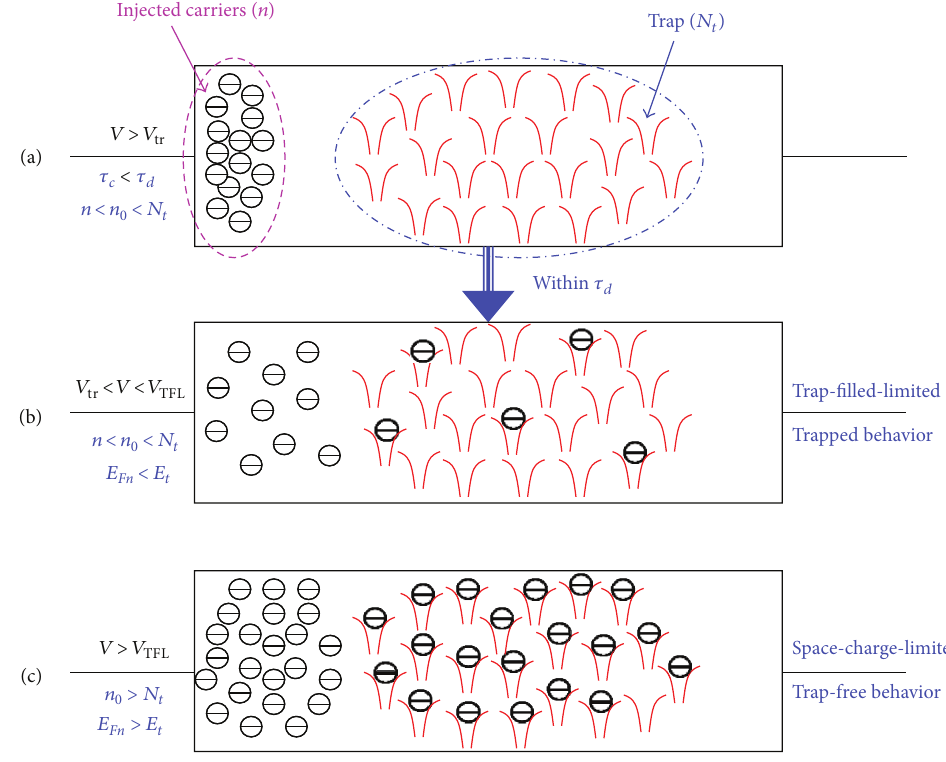
Figure 26: Carriers distribution in dielectric film under carrier strong injection ( 𝑉 > 𝑉 tr ) in space-charge-limited conduction. (a) Strong , 𝑛 < 𝑛 0 < 𝑁 𝑡 , 𝐸 𝐹𝑛 < 𝐸 𝑡 ): parts of traps are filled up injection ( 𝑉 > 𝑉 tr , 𝑛 < 𝑛 0 < 𝑁 𝑡 , 𝜏 𝑐 < 𝜏 𝑑 ), (b) trap-filled-limited ( 𝑉 tr < 𝑉 < 𝑉 TFL , 𝑛 0 > 𝑁 𝑡 , 𝐸 𝐹𝑛 > 𝐸 𝑡 ): all traps are filled up (trap-free behavior). 𝑉 tr and 𝑉 (trapped behavior), and (c) space-charge-limited ( 𝑉 > 𝑉 TFL TFL are the transition voltage at the departure from ohm’s law and TFL curve, respectively; 𝑛 is the concentration of injected carriers; 𝑛 0 is the concentration of thermally generated free carriers; 𝑁 𝑡 is the trap density; 𝜏 𝑐 is the carrier transit time; 𝜏 𝑑 is the dielectric relaxation time; 𝐸 𝐹𝑛 is the Fermi level; 𝐸 𝑡 is the trapping